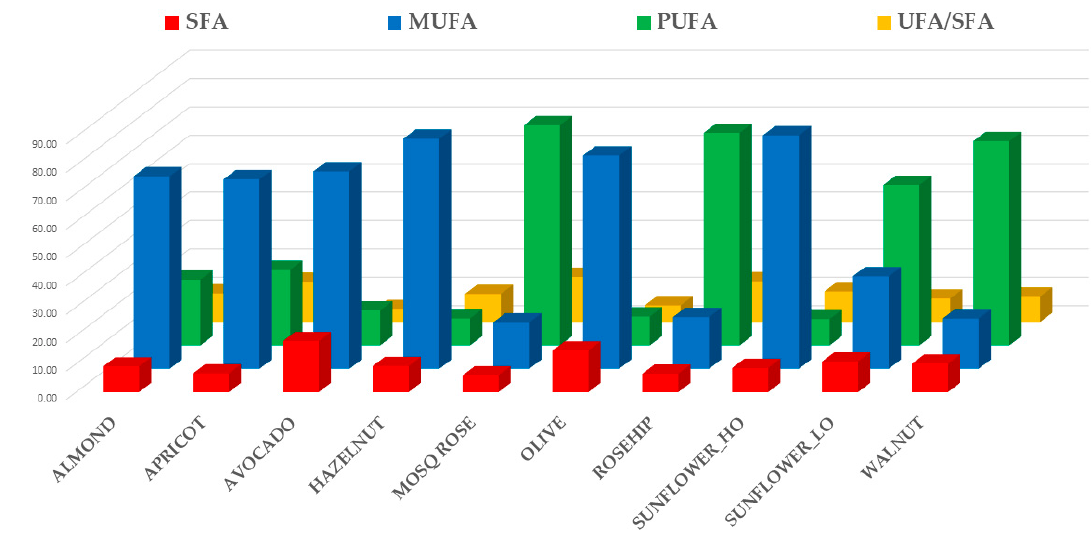
Figure 1. Mean fatty acid composition of different specialty oils. Saturated fatty acids (SFA), monounsaturated fatty acids (MUFA), polyunsaturated fatty acids (PUFA), and the ratio between unsaturated and saturated fatty acids (UFA/SFA) were highlighted.